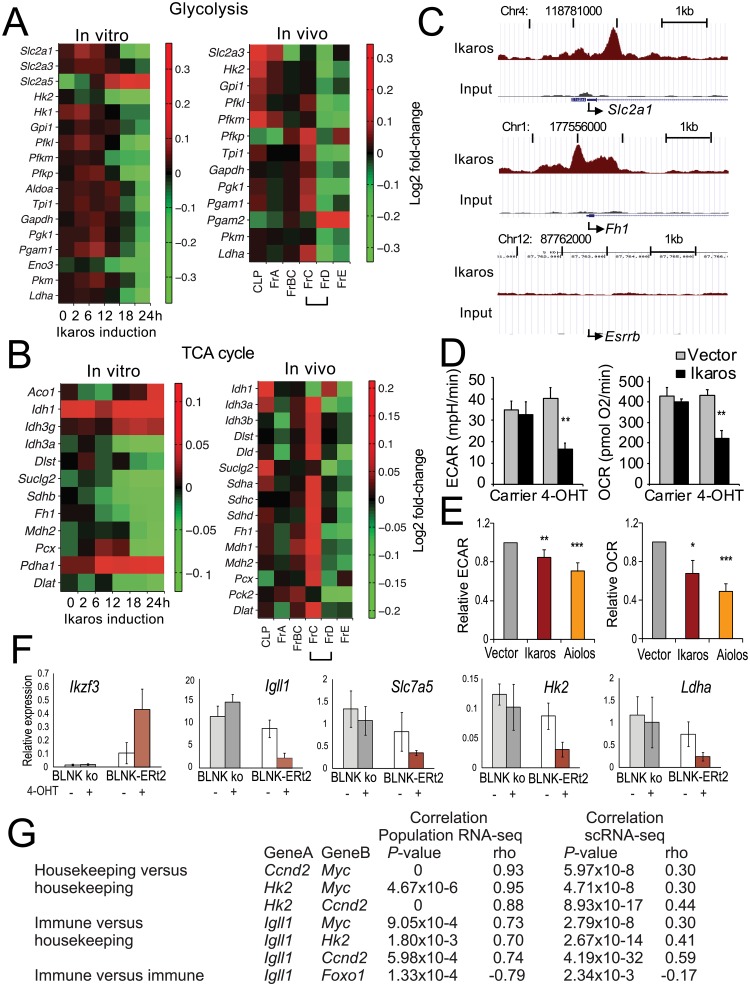
Progression from proliferating to resting stages of pre–B cell differentiation is marked by metabolic reprogramming.(A) Heat map of glycolysis gene expression in B3 cells (left) and at consecutive stages of B cell progenitor differentiation in vivo (right). The transition from Fr.C to Fr.D is marked by a bracket. The source of the numerical data underlying this figure is listed in S1 Data. (B) Heat map of TCA cycle gene expression in B3 cells (left) and at subsequent stages of B cell progenitor differentiation in vivo (right). The source of the numerical data underlying this figure is listed in S1 Data. (C) Ikaros ChIP-seq shows that Ikaros targets metabolic genes. The embryonic stem cell gene Esrrb is a negative control. Other Ikaros-bound core metabolic genes are Dlat, Hk2, Idh3g, Slc2a3, Dlst, Sdhb, Pgam1, Mdh2, Pfkl, Dld, Pfkp, Sdha, Pcx, Idh1, Fh1, Aco1, Slc2a1, Slc2a5, Aldoa, Pdha1, Pkm, Pfkm, Gpi1, Pck2, Eno3, Suclg, and Pgk1. (D) Ikaros reduces ECAR, a measure of glycolysis (left) and the OCR (right) in B3 cells after 24 h (mean ± SEM of 3 biological replicates, **P < 0.005, two-tailed t test). The numerical data underlying this figure are included in S1 Data. (E) Ikaros and the Ikaros family member Aiolos reduce ECAR and OCR in primary B cell progenitors (mean ± SEM of 6 to 7 biological replicates, *P < 0.05, **P < 0.005, ***P < 0.0001, one-tailed t test). The numerical data underlying this figure are included in S1 Data. (F) Impact of BLNK-mediated induction of Ikzf3 on the expression of metabolic genes. The numerical data underlying this figure are included in S1 Data. (G) The regulation of immune and housekeeping genes is coordinated at the level of cell populations and in single cells. BLNK, B cell linker; ChIP-seq, chromatin immunoprecipitation sequencing; ECAR, extracellular acidification; Fr.C, proliferating B progenitor; Fr.D, differentiating B cell progenitor; OCR, oxygen consumption rate; TCA cycle, tricarboxylic acid cycle.